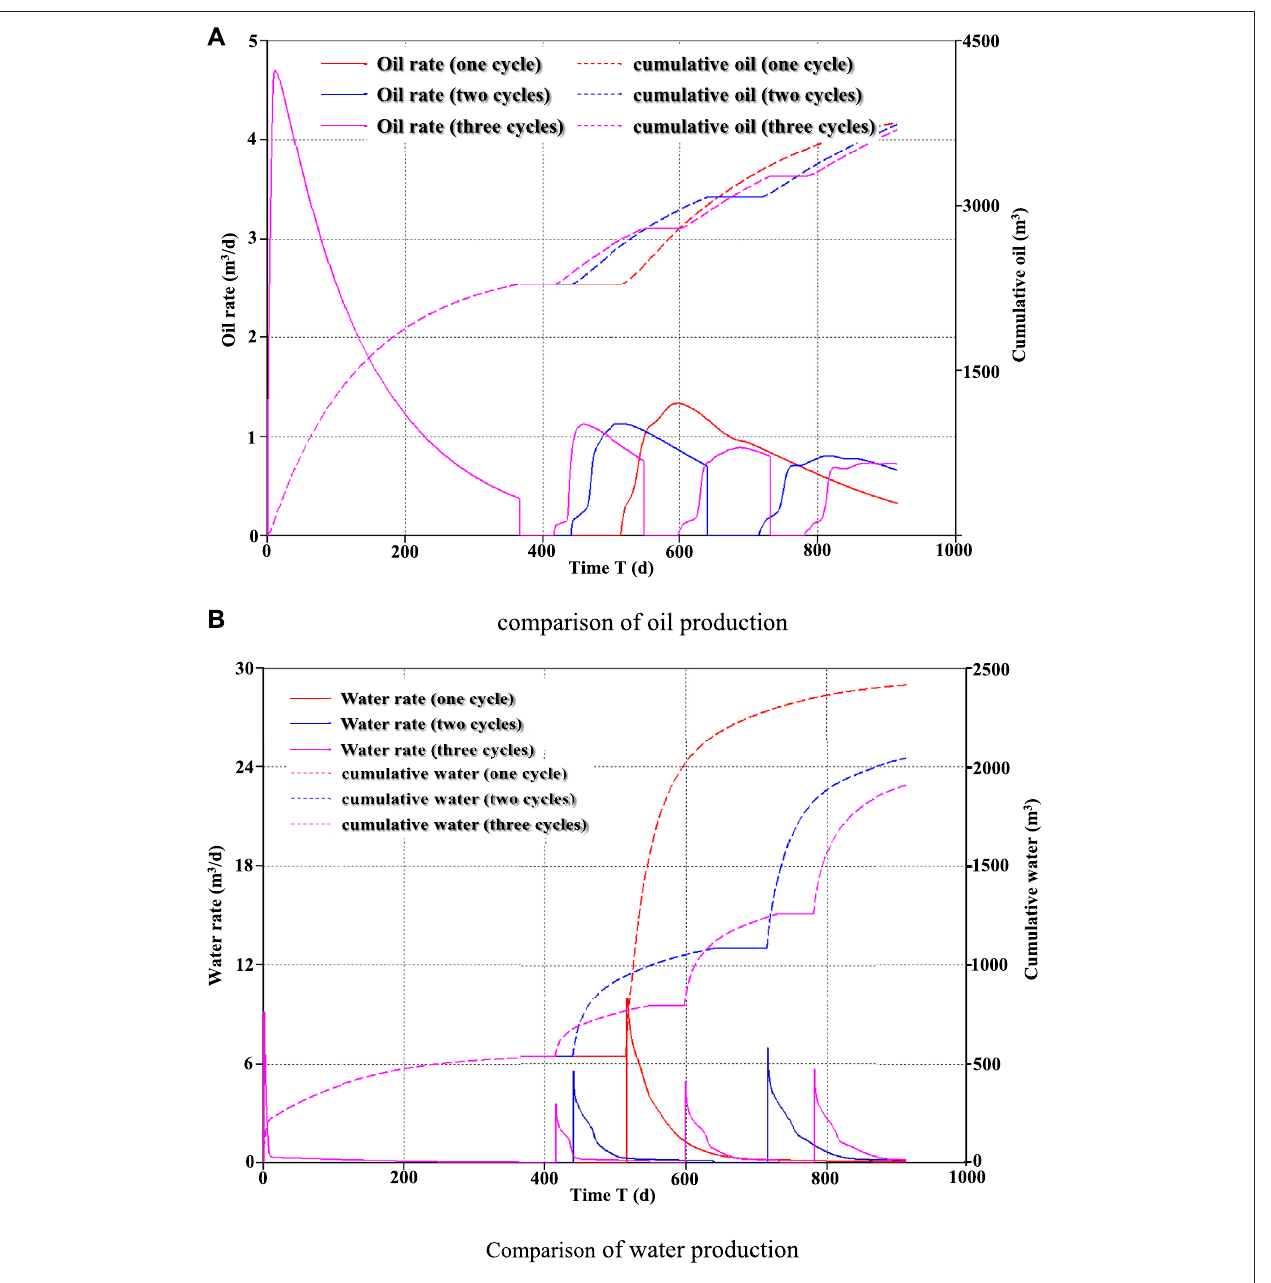
FIGURE 13 | Comparison of oil and water production with different cycles. (A) Comparison of oil production. (B) Comparison of water production